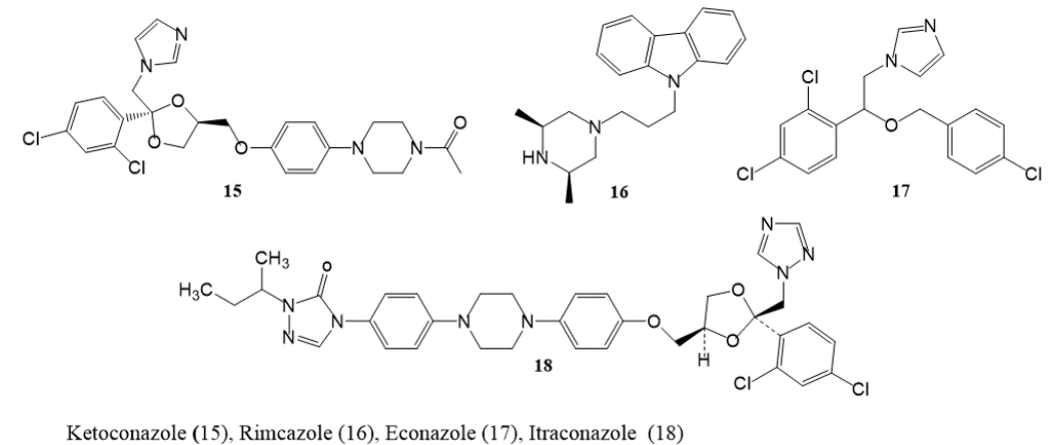
Figure 3 : Chemical structures of the common antifungal medications.